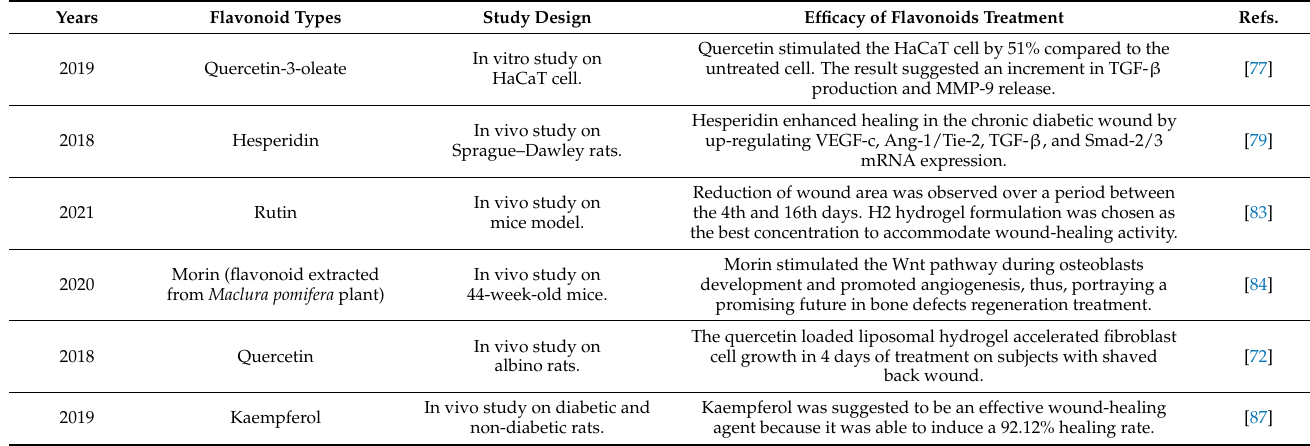
Table 2. Summary of flavonoids efficacy in in vitro and in vivo studies.